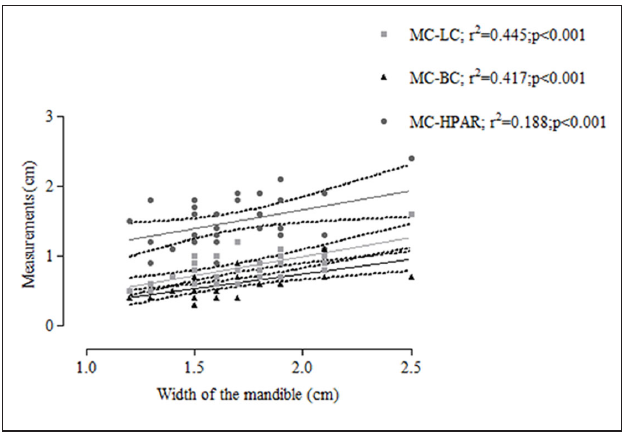
Fig. 5. Association between the width of the mandibular bone and the distance from the mandibular canal to lingual cortical (MB-LC), the distance from the mandibular canal to buccal corticals (MC-BC) and the distance from the mandibular canal to the higher point of the alveolar ridge (MC-HPAR). A positive correlation could be noticed between the (r 2 =0.821; p<0.05) and inferior heights (r 2 =0.423; p<0.05),